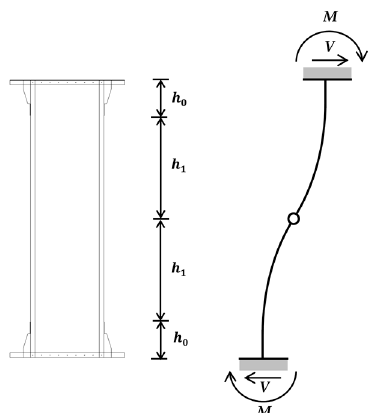
Figure 2. Free body diagram of an integrated panel ( h o is the height of the hold-down, and h 1 is half the height of the integrated member except the hold-down).